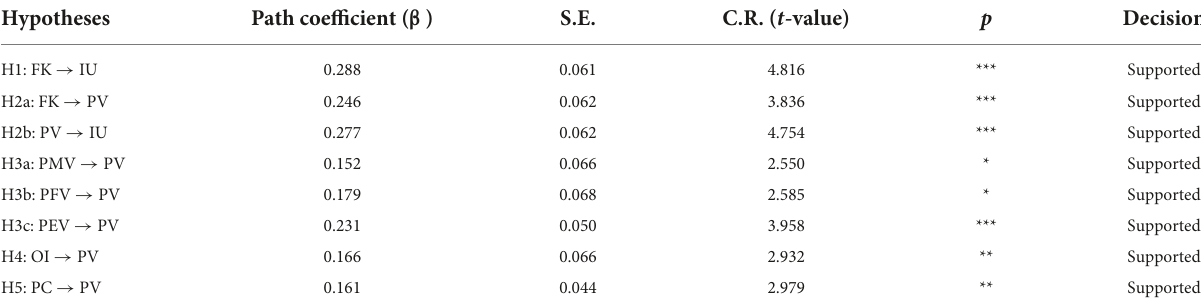
TABLE 7 Results of the path coefficient analysis.